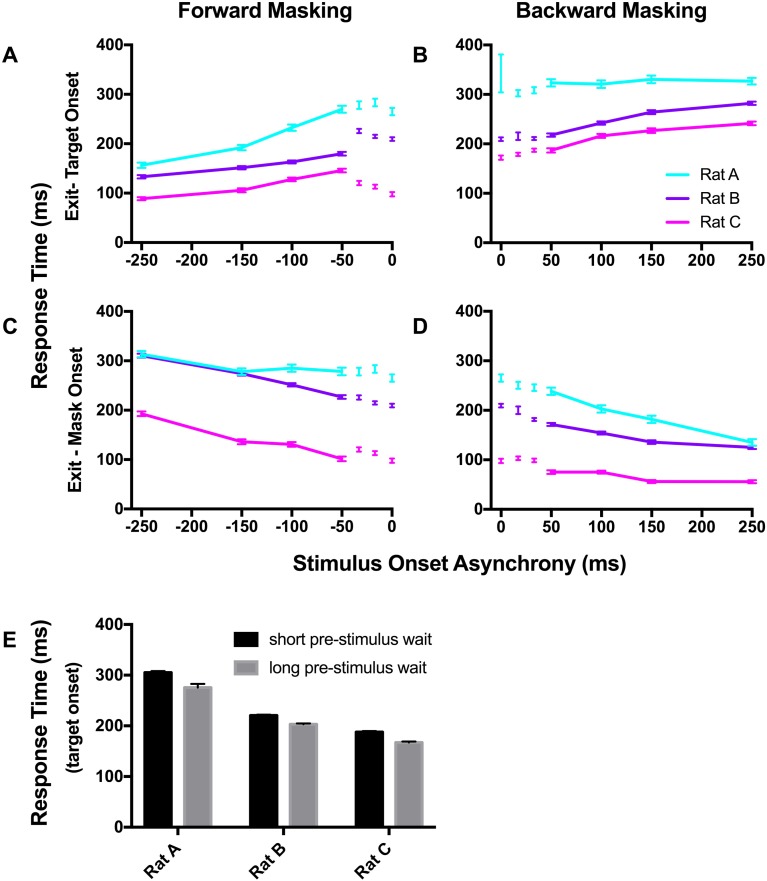
Rat response times are influenced by trial duration but not by visual masking.Response times were measured for the 42 ms target condition from the (A, B) target onset and (C, D) mask onset to the time that the rat exited the central sensor. For each rat, all response times are represented as mean (SE). Response times measured at the temporally overlapping SOAs, where target duration was truncated, are presented separate from the remainder of the curve. At a SOA of 0, only a mask stimulus was presented. (E) rat response times measured from the target onset divided according to the duration of the pre-stimulus hold, collapsed across SOA (pre-stimulus hold: 350–400 & 400–450 ms). For rat A, data measured from the target onset represents a summary of performance across an average of 453 forward (496 backward) trials/SOA and 85 sessions, mask onset data 551 (517) trials/SOA and 85 sessions. Rat B–target onset: 620 (743) trials/SOA; 66 sessions, mask onset: 690 (632) trials/SOA; 66 sessions. Rat C–target onset: 341 (419) trials/SOA; 65 sessions, mask onset: 641 (572) trials/SOA; 65 sessions.